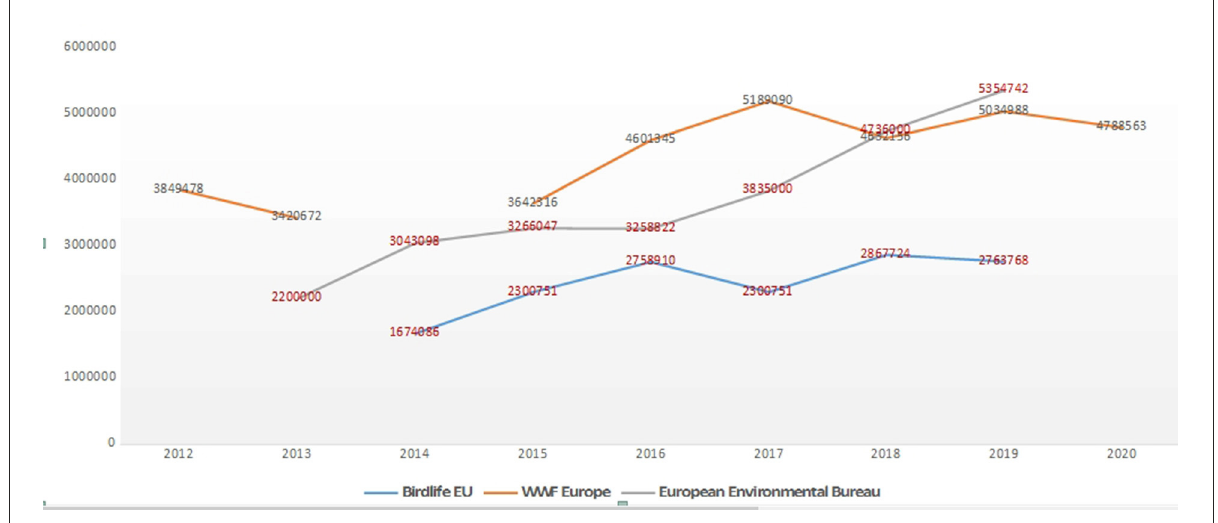
FIGURE12 Three Environmental NGOs in Europe. Growth charts. Data source: Birdlife, WWF Europe and European Environmental Bureau annual reports. Freely accessible from these organisations’